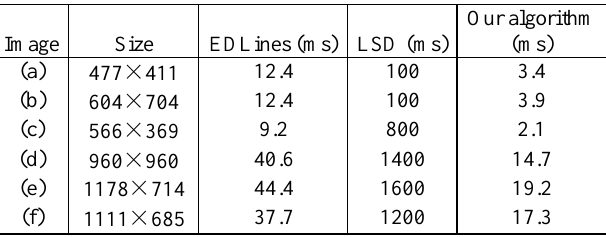
Table 1. Comparison of computational